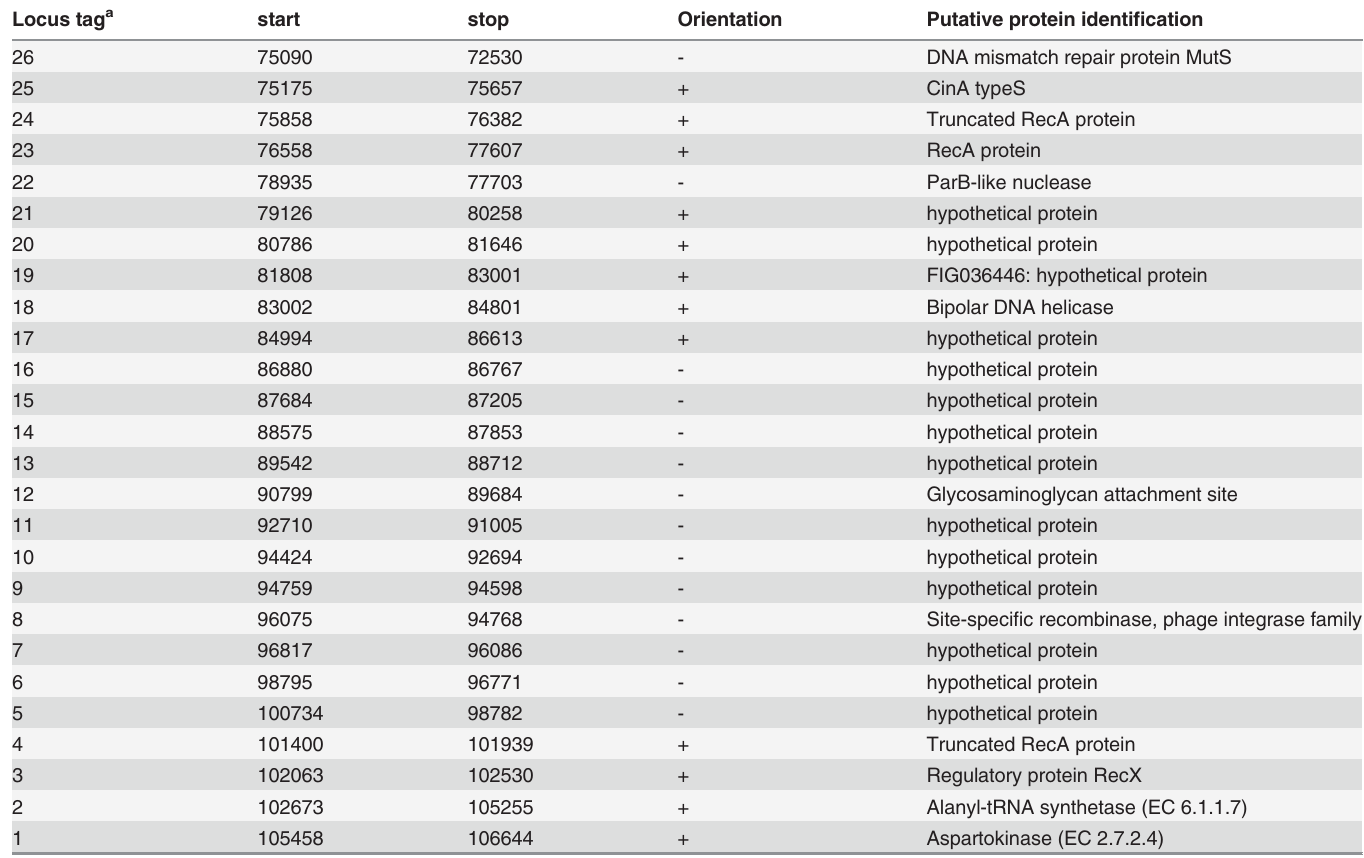
Table 3. Annotation of the recA region from the genome of strain 090 – 96 by RAST server [22]. Locus tag a